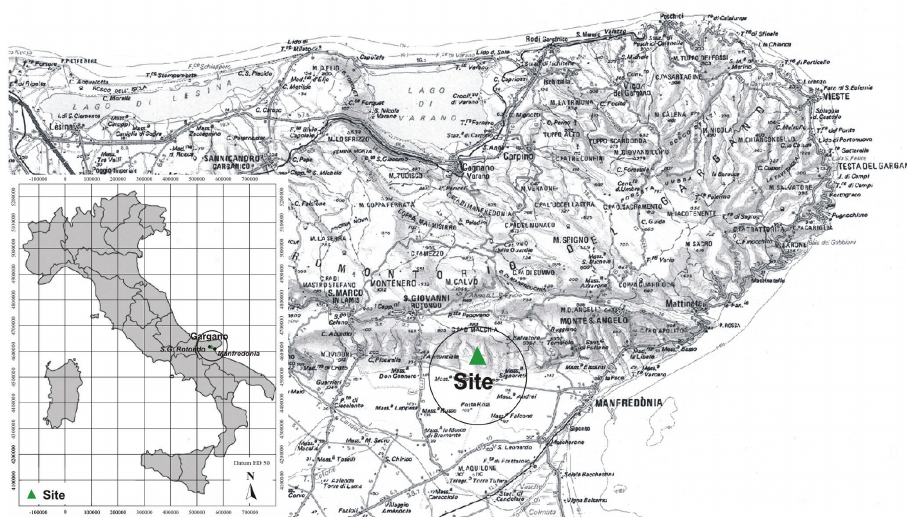
Figure 4. Geographic range and distribution map of Cerinthe retorta in